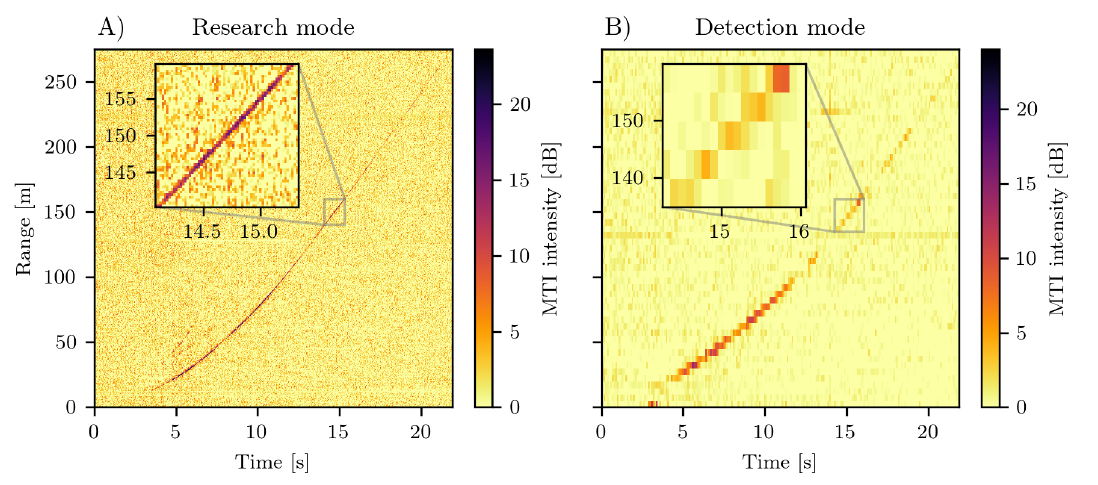
Figure 6. A car departs from the radar location at range 0m. The colouring is the intensity of the moving target identification for ( A ) the high resolution research mode and ( B ) the low resolution detection mode. The insets show a zoom of approximate similar range and time extent, thus the difference in resolution of both measuring modes can be seen. Note, the panels show two different data sets as both modes cannot be measured